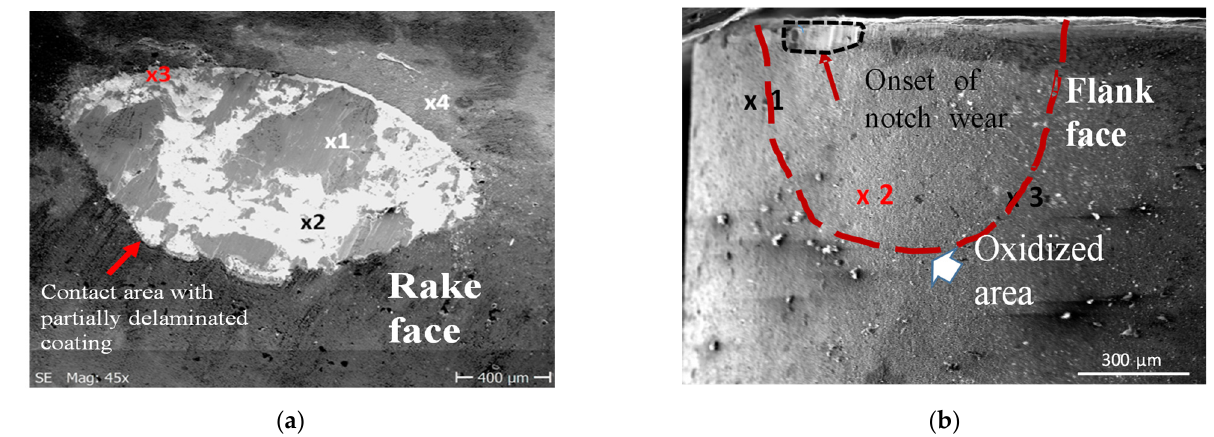
Figure 8. SEM images of rake ( a ) and flank ( b ) faces obtained after machining of IN718 workpiece with the cutting speed of 200 m/min; machining time of 30 s [13].